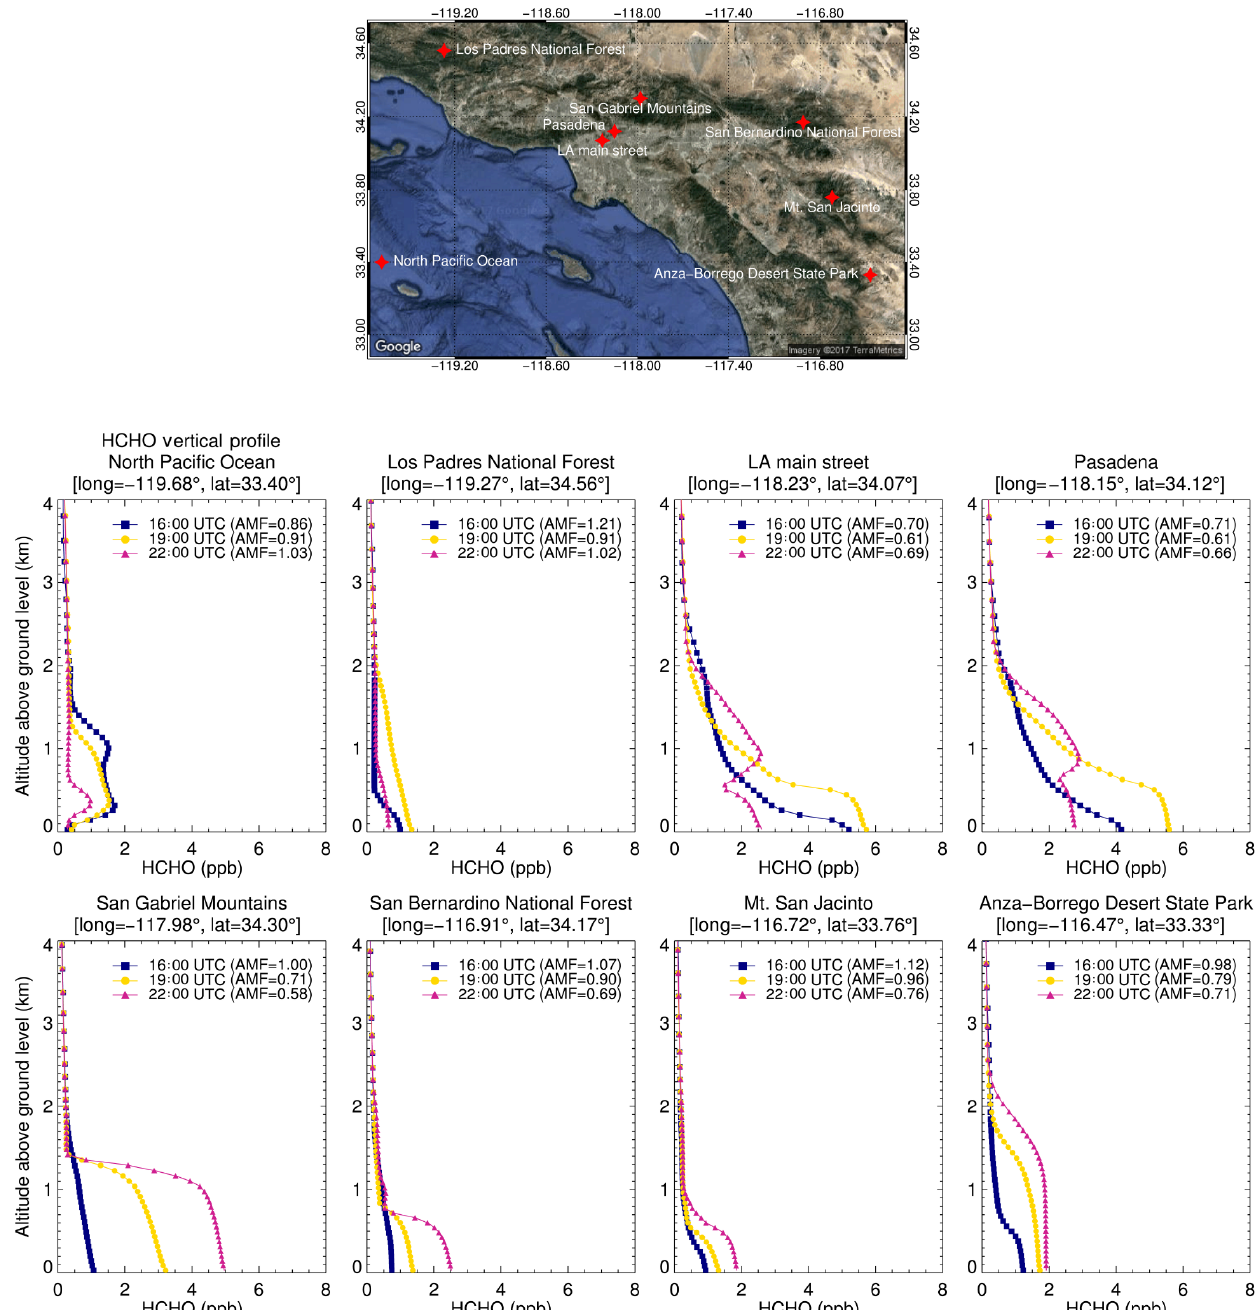
Figure 4. Vertical profiles of HCHO are shown for various points of interest (red symbols on a Google map). Blue, orange, and magenta lines represent 16:00, 19:00, and 22:00UTC (or 09:00, 12:00, 15:00PDT), respectively, on 4 May 2010. The altitude above ground level is shown. The same plot with the unit of moleculescm − 3 is shown in the